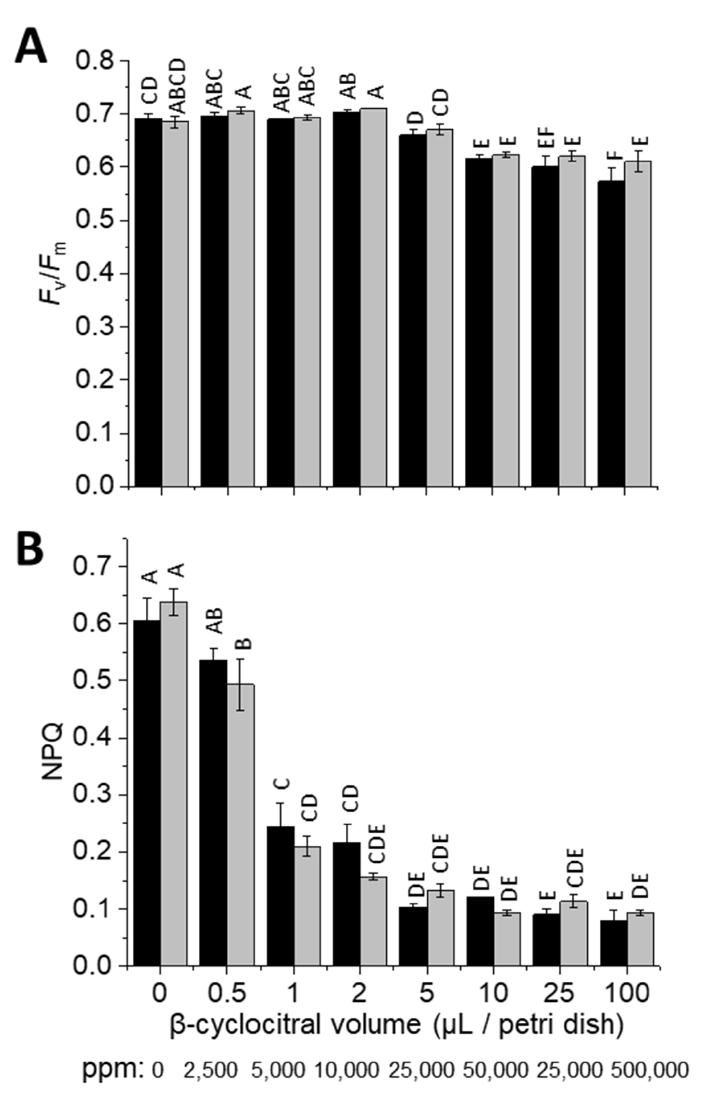
Figure 1. Effect of exogenous β -cyclocitral on F v / F m and NPQ in Chlamydomonas reinhardtii. ( A ) Measurements of F v / F m and ( B ) NPQ in 4 h HL-acclimated cultures were made after 4 h of treatment under very LL (see methods), of cell-wall-containing wild type (WT-4A; black bars) and cell-wall-less (cw15; grey bars) cultures, n = 3 ± SD, with distinct letters indicating significant differences ( p < 0.05). Aldehydes can be detoxified by GSH and associated enzymes, such as GSTS1. Thus, the response of β -cyclocitral on GSH concentrations was also measured up to 1500 ppm (0.3 µ L/Petri dish), and after 4 h, no effect was observed (Figure S3). Overall, the lack of decrease in F v / F m and lack of change in GSH concentrations indicated that β -cyclocitral was not a cytotoxic aldehyde at treatment with up to 1500 ppm, a concentration at which the RES acrolein is lethal [13]. Moreover, the significant impact of β -cyclocitral on NPQ in WT-4A and cw15 showed that this aldehyde could enter the chloroplast of C. reinhardtii and that the cell wall was not a hindrance to influx. Therefore, we felt confident to be able to assess the signalling properties of β -cyclocitral in exogenously- treated